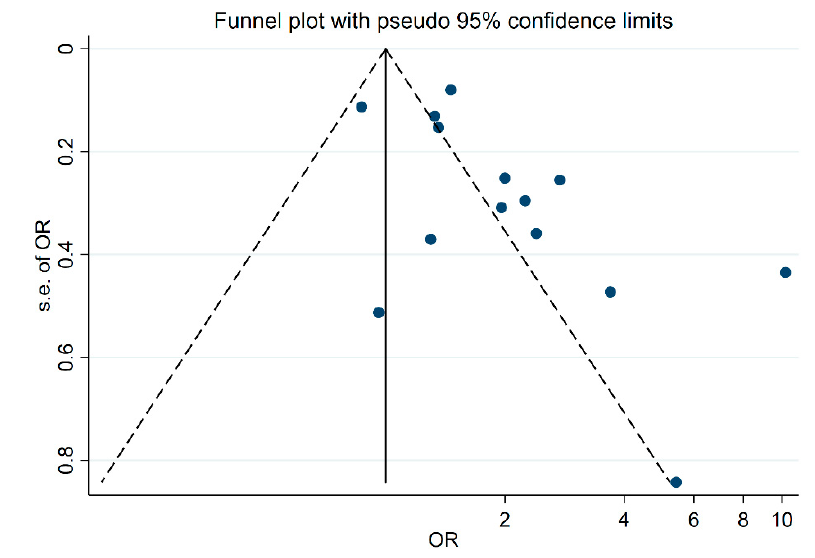
Figure 7. The funnel plot to check for publication bias.